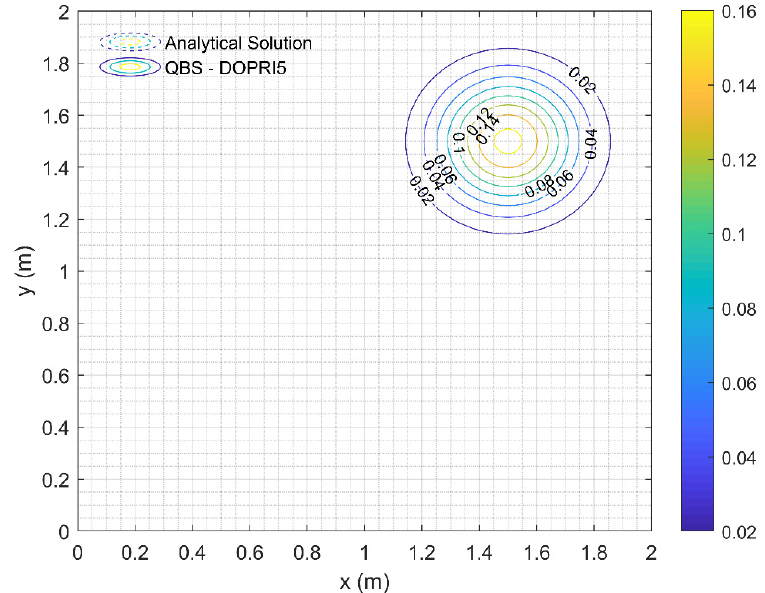
Figure 1. Approximate solution obtained with QBS-DOPRI5 at time (cid:1872) = 1.25 s with ∆(cid:1876) = ∆(cid:1877) =